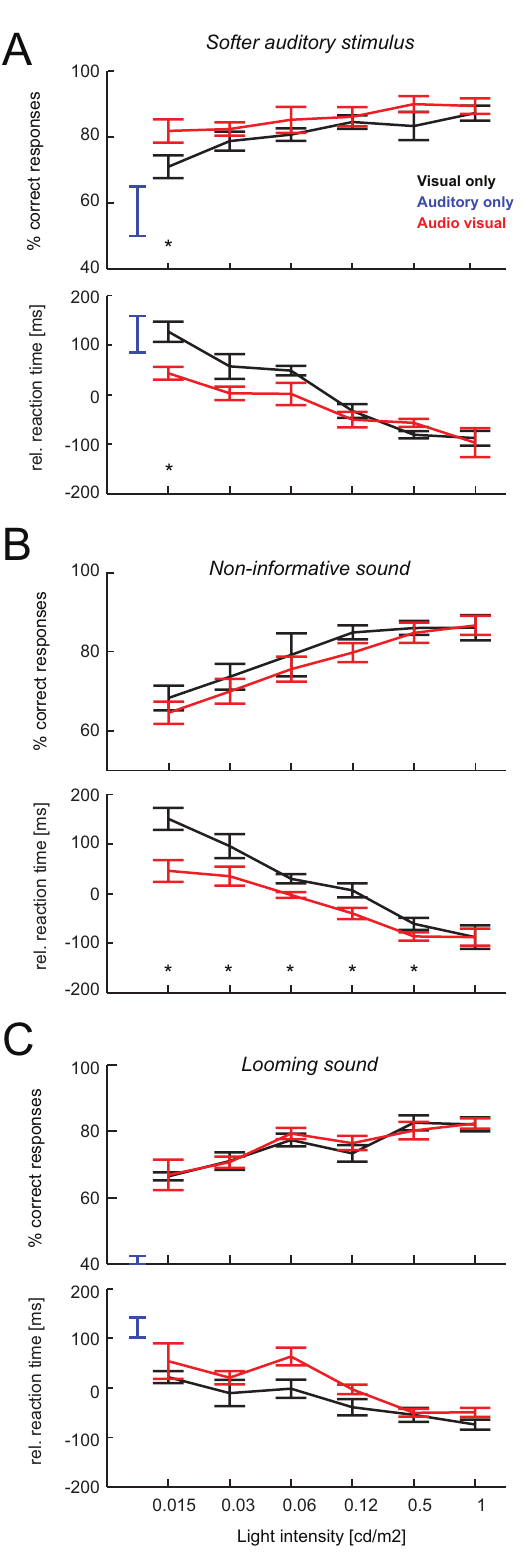
Figure 3. Behavioral performance – controls and additional paradigms. Behavioral performance (% correct responses, upper panel) and reaction times (lower panel) as in Figure 2 (n=4 animals each). Stars indicate statistical significance (ANOVA p , 0.05). A) Paradigm with a softer auditory stimulus (65 dB). B) Paradigm